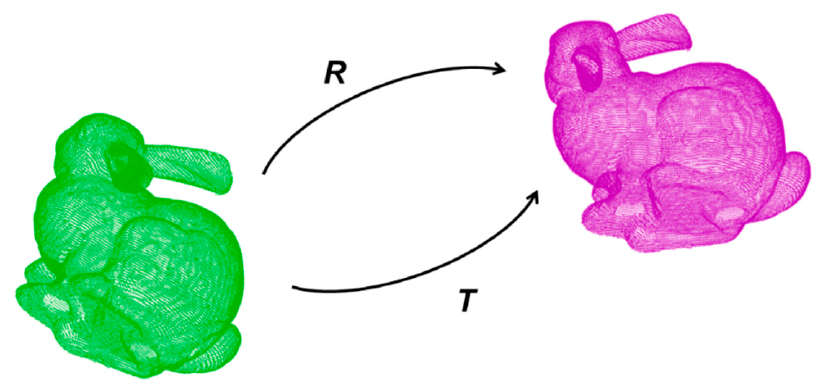
Figure 2. Three-dimensional spatial transformation process of point cloud data by rotation matrix R and translation matrix T.